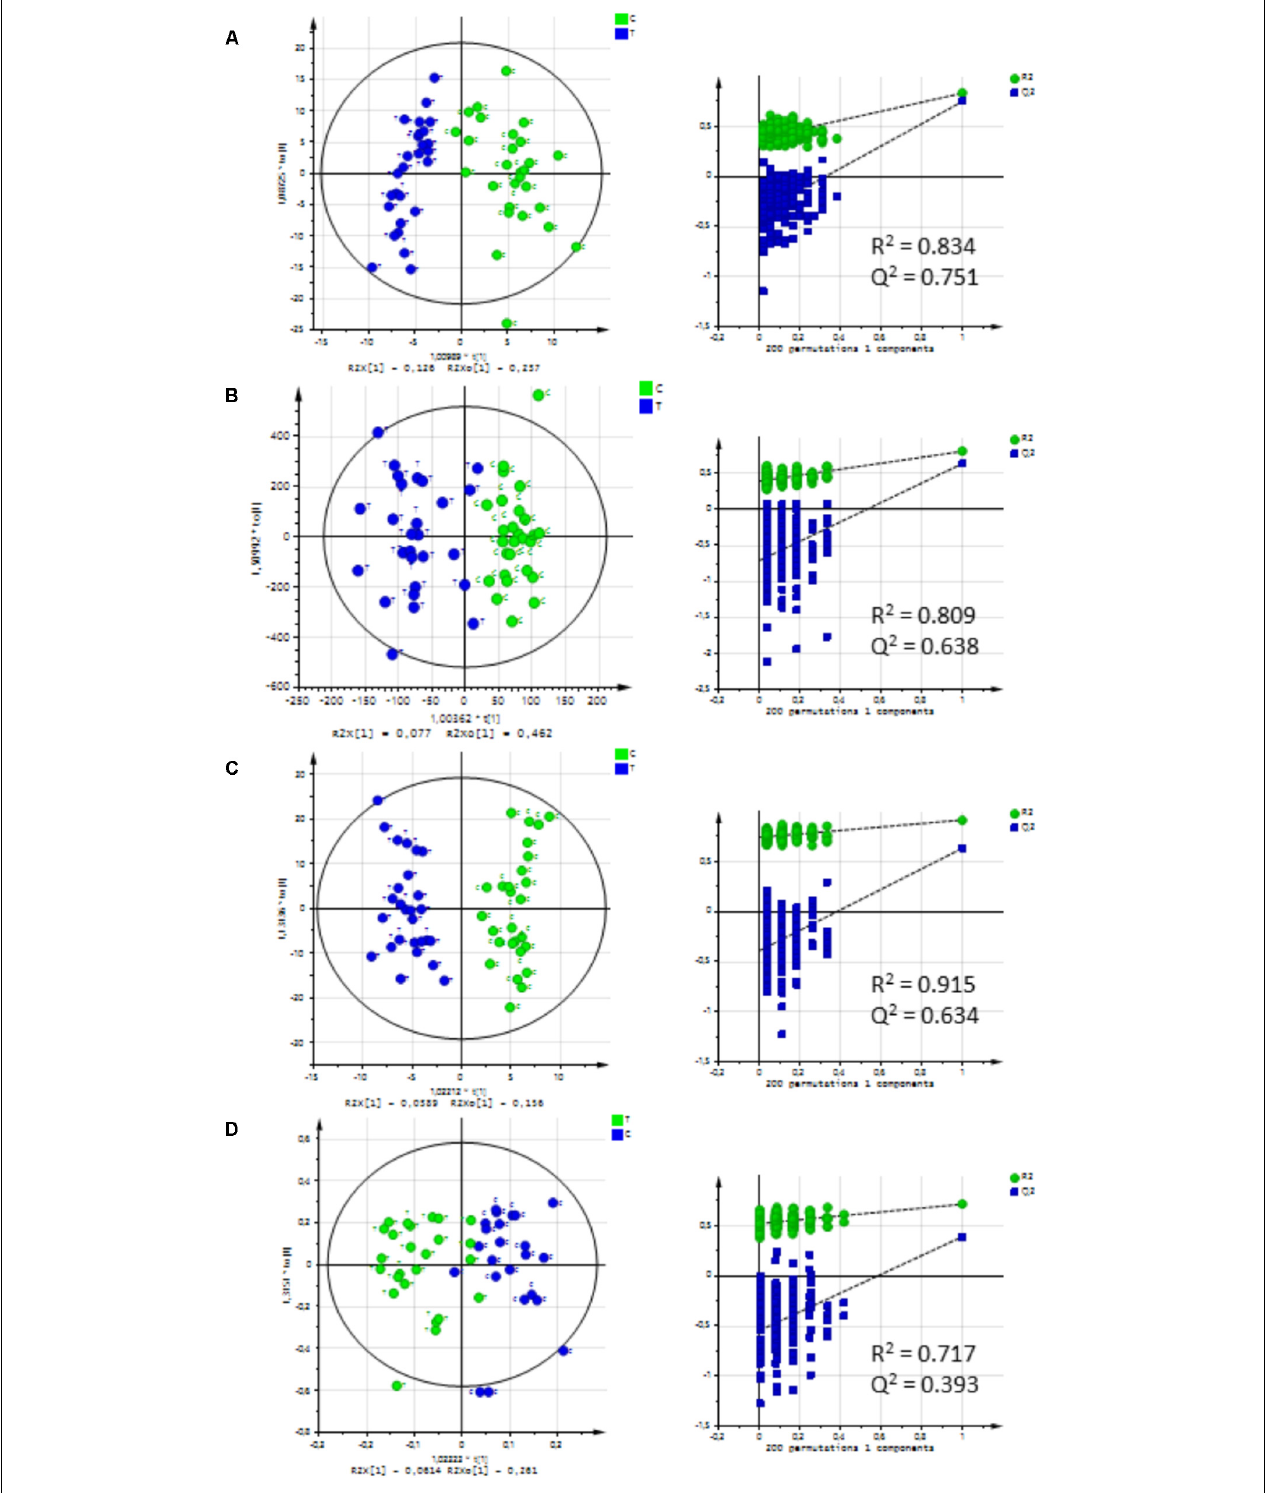
FIGURE 3 | Orthogonal projections to latent structures-discriminant analysis (OPLS-DA) and validation permutation tests of rumen fluid and urine samples from control (C, n = 28 rumen fluid, n = 27 urine) and treated (T, n = 27) lambs at 20 weeks of age. (A) Rumen fluid analyzed by LC-MS (284 variables). (B) Rumen fluid analyzed by NMR after variable selection (582 of 641 variables). (C) Urine analyzed by LC-MS (848 variables). (D) Urine analyzed by NMR after variable selection (939 of 1030 variables).